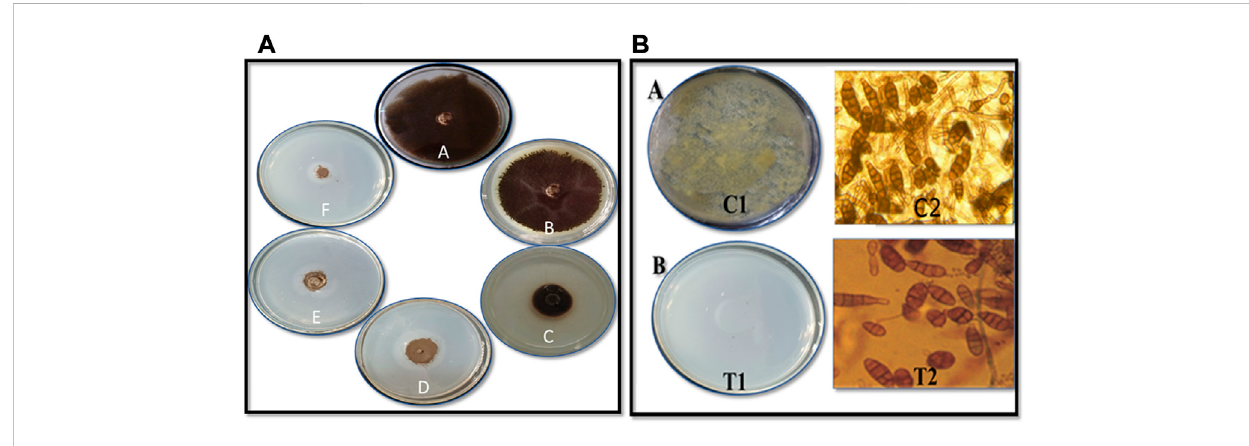
FIGURE 8 Antifungal activity of CuO nanoparticles against Alternaria sp. on (A) mycelial growth inhibition by poisoned food technique (A) Control (B) 50 μ g mL − 1 (C) 75 μ g mL − 1 (D) 100 μ g mL − 1 (E) 150 μ g mL − 1 and (F) 200 μ g mL − 1 CuO nanoparticles (B) Spore germination inhibition by (A) Pour plate